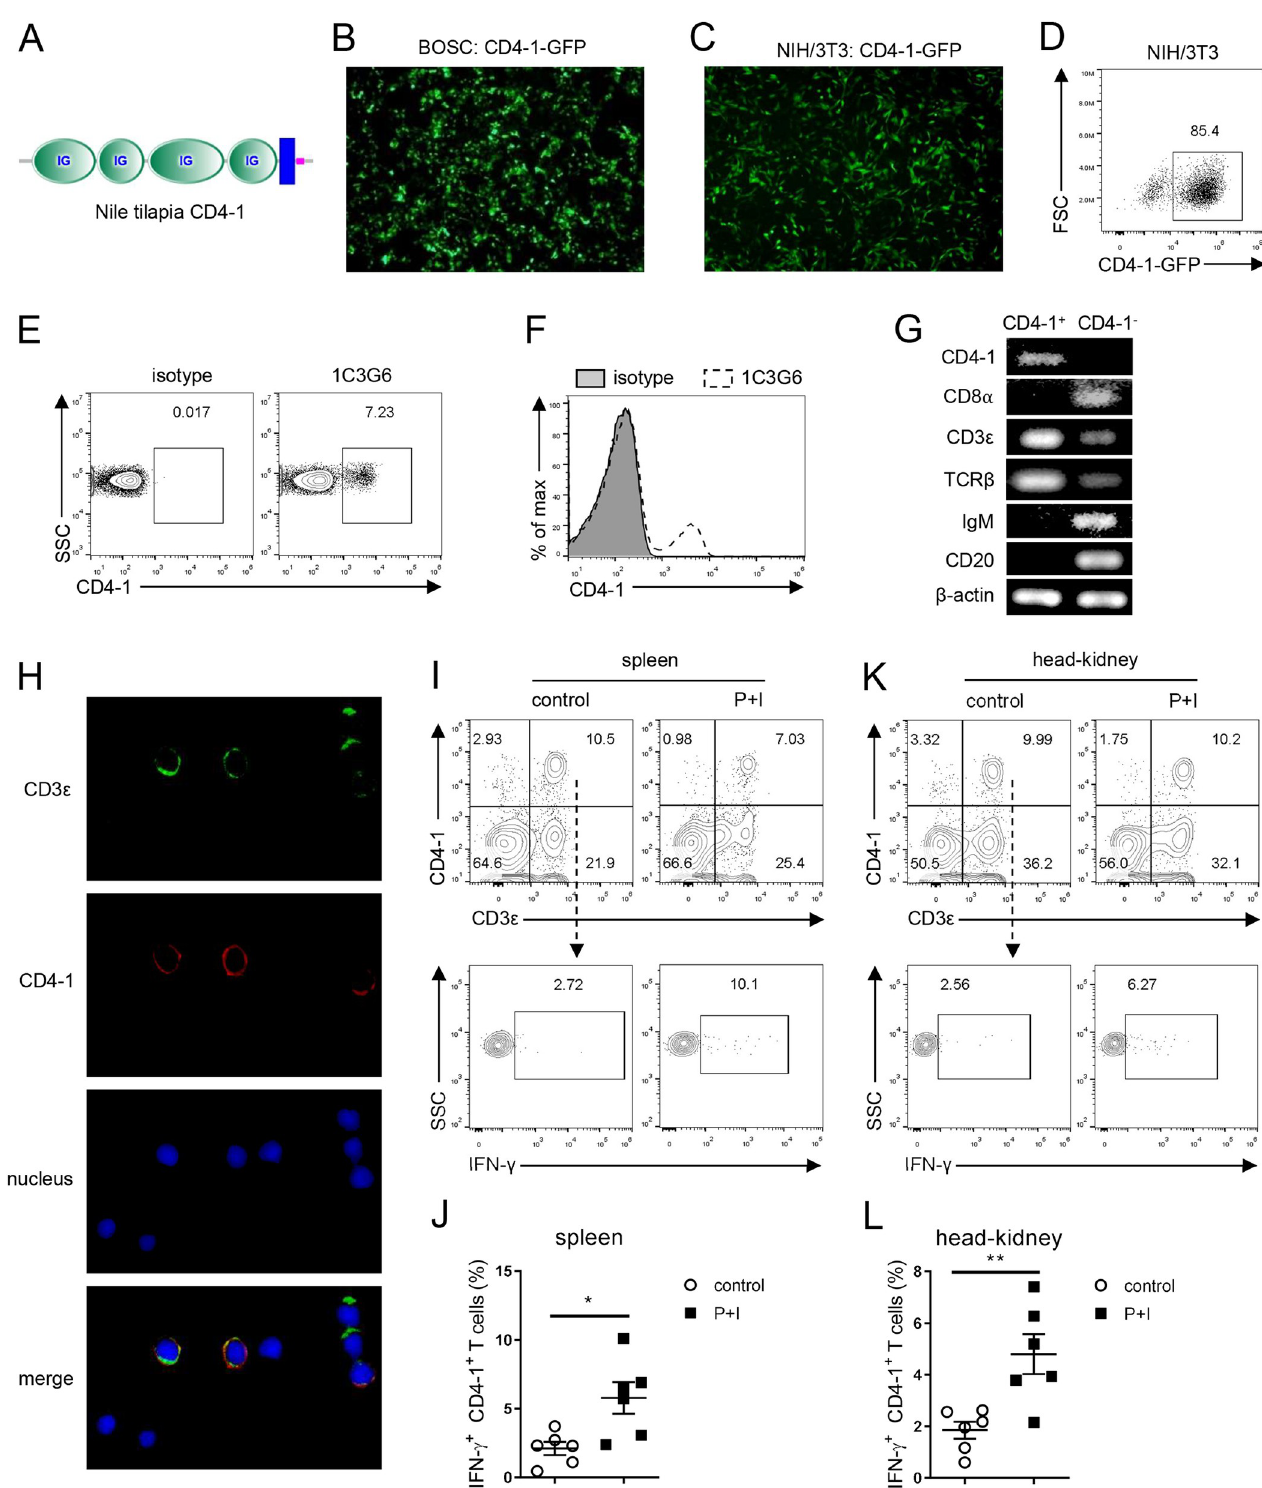
Fig 2. Th1 cells are present in tilapia. ( A ) Domain prediction of tilapia CD4-1. The accession number of CD4-1 was listed in S1 Table. ( B ) BOSC23 cells were transfected with MIGR1-CD4-1 to produce retrovirus, and the fluorescence microscopy showed the BOSC23 cells expressing CD4-1. ( C , D ) Fluorescence microscopy ( C ) and flow cytometry ( D ) showed the NIH/3T3 cells expressing tilapia CD4-1. ( E , F ) Dot plots ( E ) and overlaid histogram ( F ) showed the tilapia spleen leukocytes stained with the CD4-1 mAb 1C3G6. ( G ) Gene expression profiles of CD4-1 + and CD4-1 - lymphocytes were detected by RT-PCR. ( H )